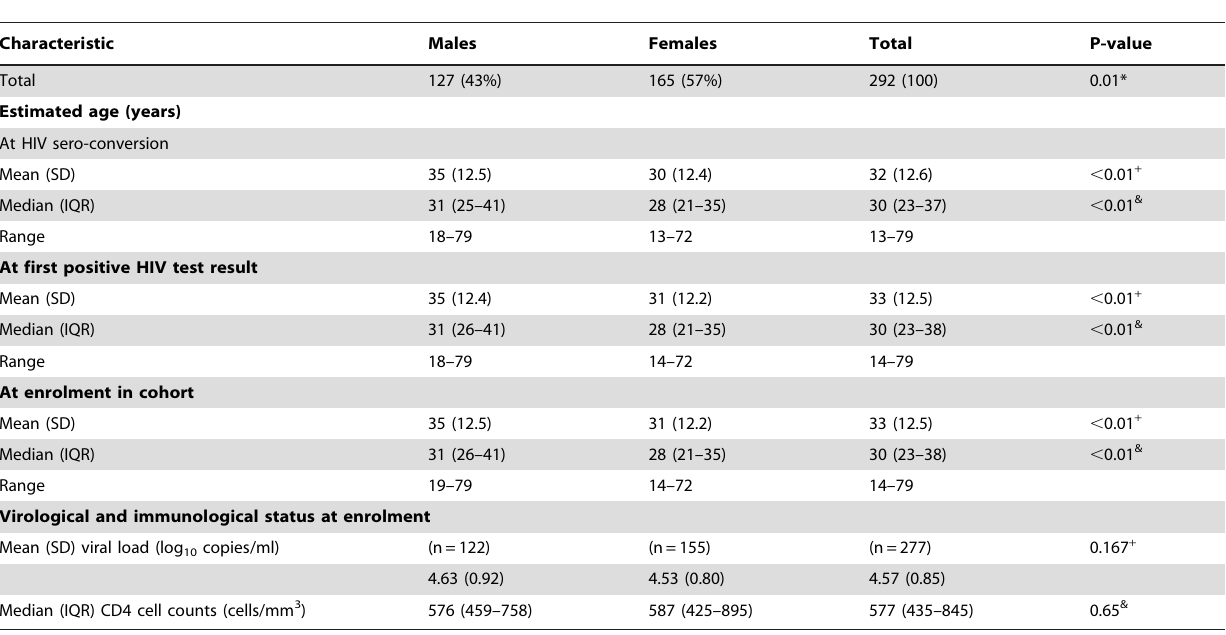
Table 1. Characteristics of HIV-1 incident cases in the cohort: